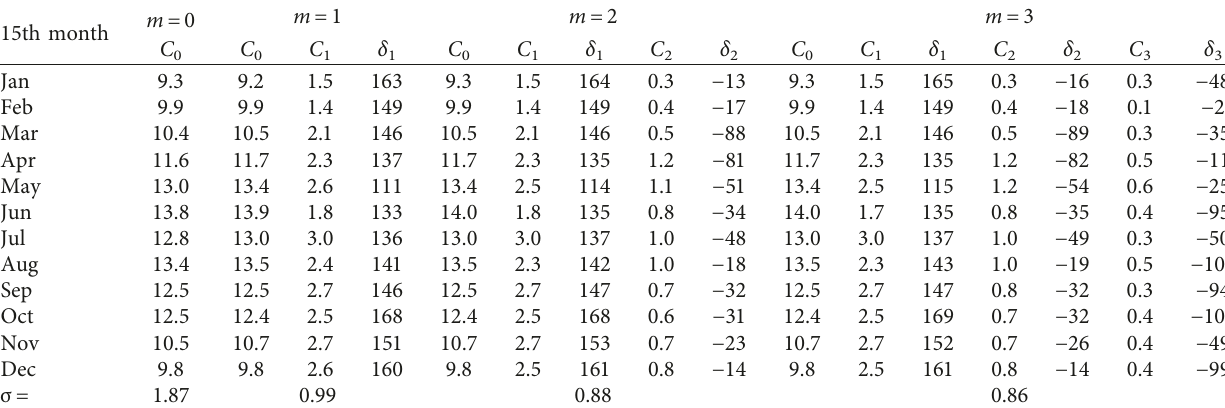
Table 2: Fourier parameters for the water-vapor pressure p